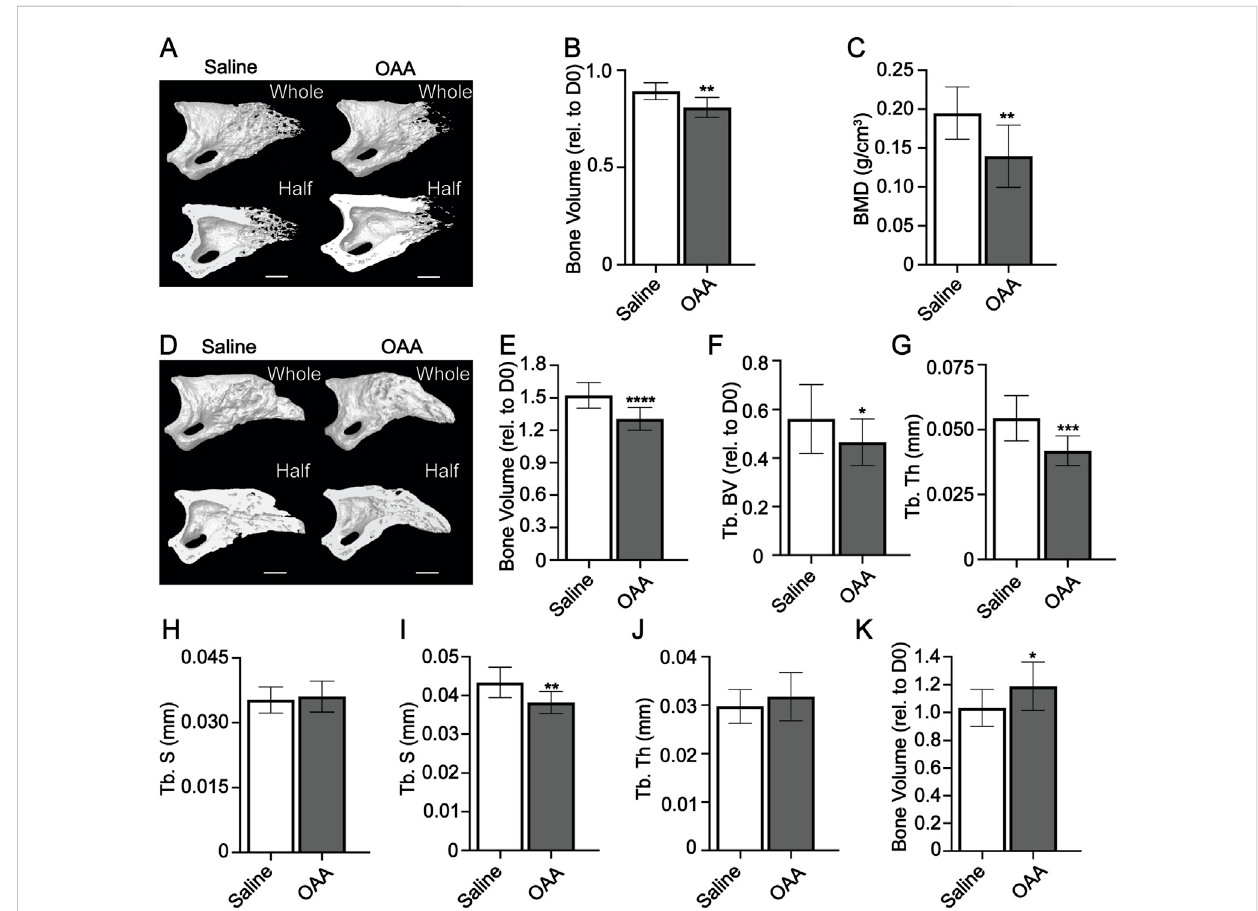
FIGURE 3 OAA-enhanced regeneration is dependent upon dosing during blastema and bone phases. (A) Radiographic images of whole and bisected digits in young mice at day 14 following administration of saline (Control) and OAA from day 10 – 14 following amputation of the distal P3. Bar, 200 µm. (B) Bone volume(relativetoday0). (C) Bonemineraldensity(BMD)atday14inmicetreatedwithsalineandOAAfromday10 – 14. (D) Radiographicimagesofwhole and bisected digits in young mice at day 28 following administration of saline (Control) and OAA from day 14 – 28 following amputation of the